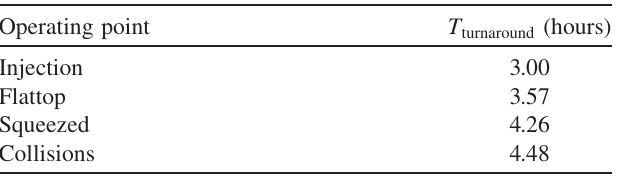
TABLE VI. Average turnaround times in the 2010 LHC proton move in parallel to the beam. A speed-up by a factor of up is the time con- run from [25]. The turnaround time T to 6 for both modes, respectively, was achieved when turnaround sumed from the point of beam dump until the machine is cycled back to the required operating point.